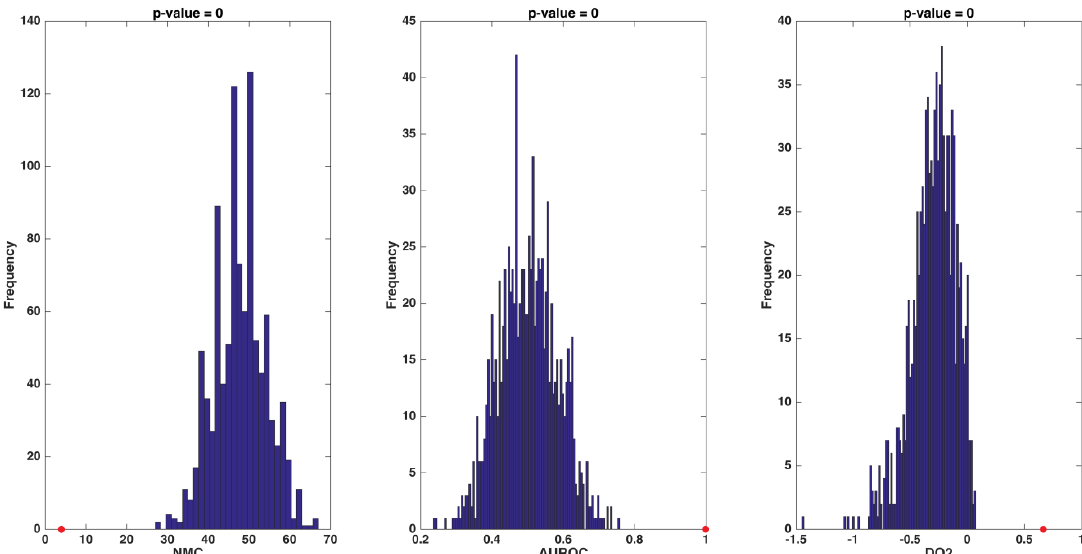
Figure 2. Distribution of values of number of misclassifications (NMC), area under the receiver operating characteristic curve (AUROC), and discriminant Q2 (DQ2) under their respective null hypothesis as estimated by permutation tests (blue histograms) and the corresponding values obtained by the partial least squares-discriminant analysis model on unpermuted data (red circles). Values obtained on the real dataset (red circles) fall outside of the corresponding null hypothesis distribution (blue histograms), corresponding to a p < 0.05.